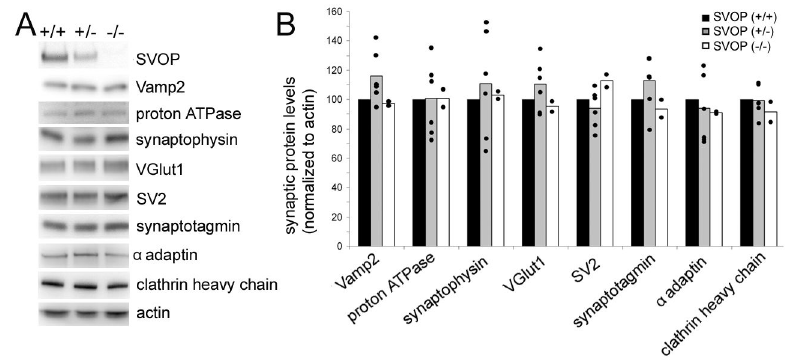
Figure 5. Disruption of the SVOP gene does not change the expression of other synaptic proteins. A) Shown are representative Western blot analyses of brain post nuclear supernatant isolated from littermate mice of the indicated genotype. The linear range was determined for each antibody used in Western blot analyses. The amount of protein loaded for each analysis fell within the linear range. Specifically, 5µg of protein were used for detecting SV2, α –adaptin, proton ATPase and VGlut1; 2.5µg of protein were used for detecting synaptophysin and synaptotagmin; 1.5µg of protein were used for detecting Vamp2 and clathrin heavy chain. The antibody used to detect SVOP is derived against a peptide in the amino terminus of SVOP. B) Quantification of synaptic protein levels normalized to the amount of actin in the same lane. Brain tissue from 4 wild type, 6 heterozygous and 2 homozygous pups was analyzed. The histograms represent the mean value of expression normalized to wild type values in the same blot. Each dot represents a single datum. Loss of SVOP did not significantly alter expression levels of other synaptic vesicle proteins including Vamp2, the proton ATPase, synaptophysin, VGlut1, SV2, synaptotagmin as well as endocytic proteins such as α adaptin and clathrin heavy